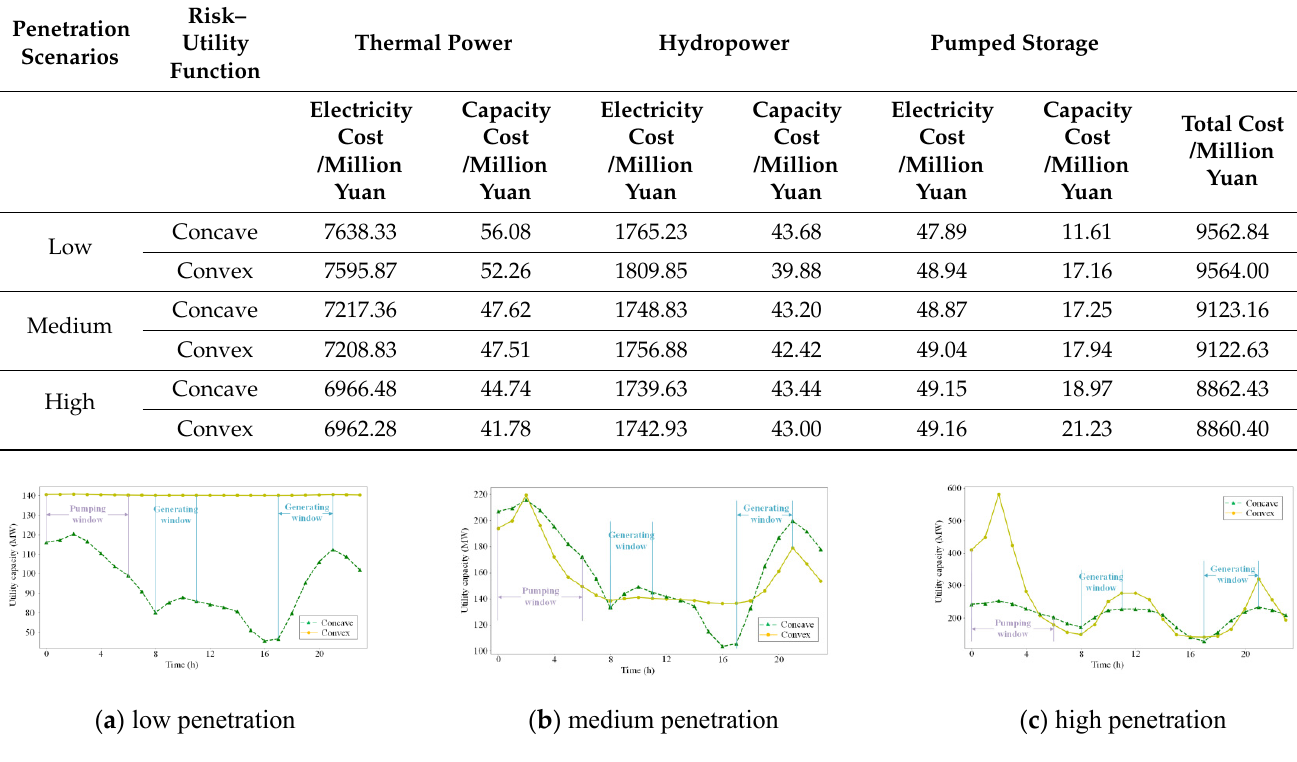
Figure 6. Utility Capacity of Pumped Storage.